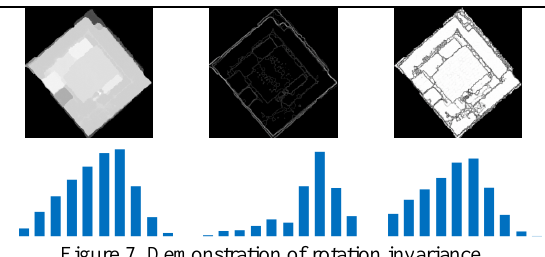
Figure 9. Retrieval results of the compared method.